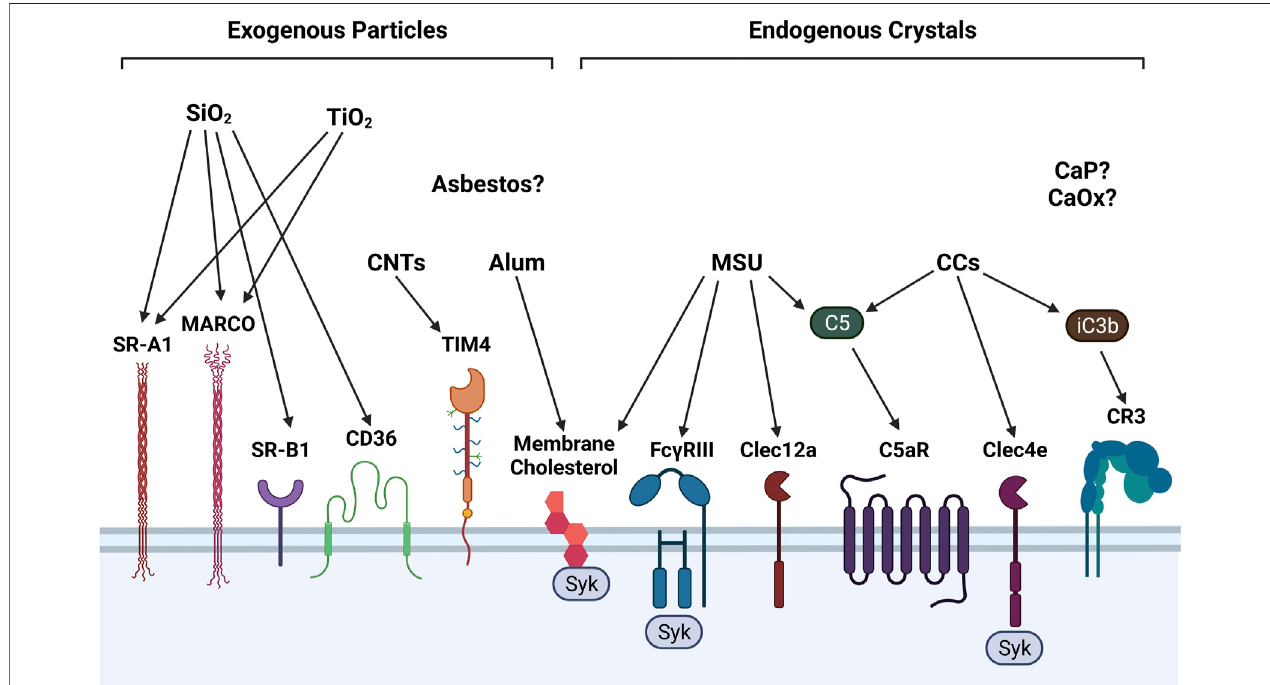
FIGURE 1 | Surface receptors involved in detecting exogenous and endogenous particles. Phagocytes employ a diverse assortment of membrane receptors to recognize and ultimately phagocytose particles, some of which are depicted in this illustration. SiO 2 is recognized by scavenger receptors SR-A1, MARCO, SR-B1, CD36. TiO 2 is recognized only by SR-A1 and MARCO. CNTs are recognized by phosphatidylserine receptor Tim4. Alum and MSU interact directly with membrane cholesterol moieties tostimulate Syk signaling. MSU and CCs activate complement components C5and iC3b, which stimulate C5aR and CR3, respectively. MSU alsobindstoFc γ RIII/CD16andC-typelectin(Clec)-12a.Onhumanphagocytesonly,CCsarerecognizedbyClec4e.Surfacereceptorsforasbestos fi bersandcalcium- containing salts (e.g., CaP, CaOx) have not yet been identi fi ed.